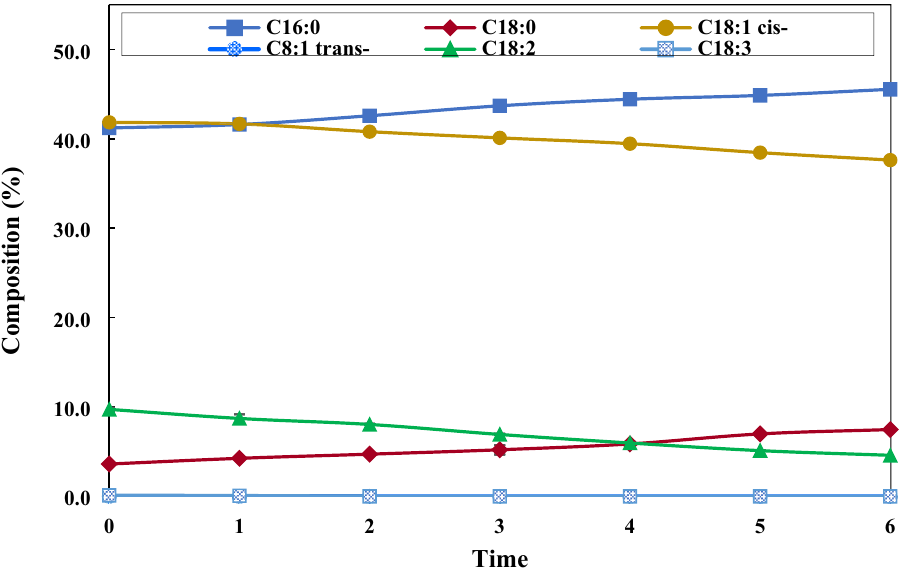
Figure 6. Effect of reaction time on FAME composition changes (100 W, 1 mm gap and 80%H 2 at room temperature).